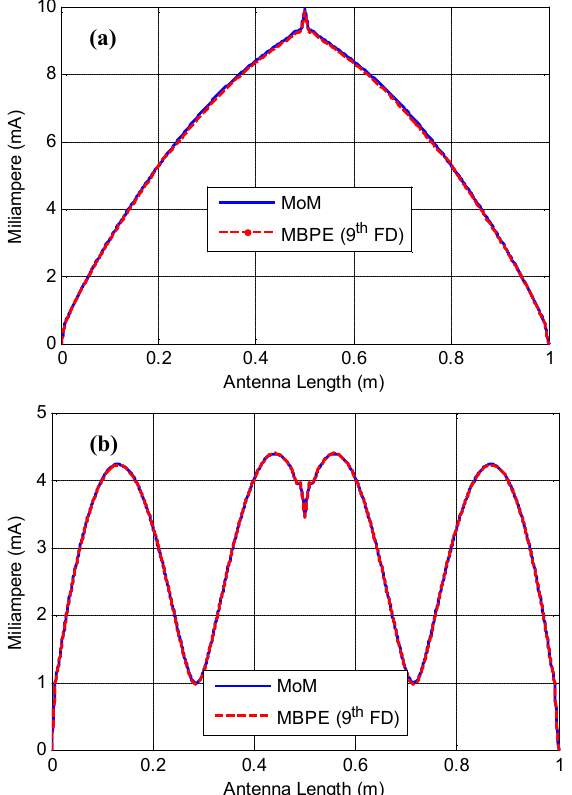
Figure 5: Current distribution on the thin wire antenna at a) f = 0.4 f o and b) f = 1.6 f o .